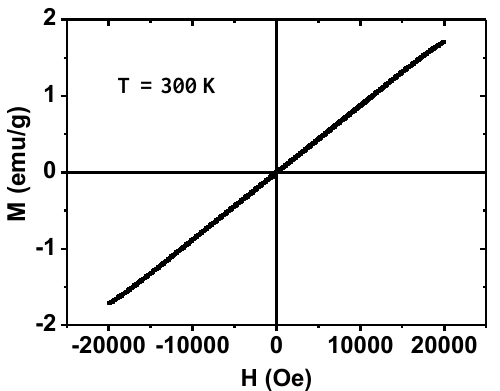
Figure 5 . M–H curve of the PMVEMA-coated ultra-small Gd 2 O 3 NPs at T = 300 K, showing paramagnetism. The M value is the net M value of the Gd 2 O 3 NPs only without PMVEMA, which was estimated using their net mass obtained from the TGA curve.